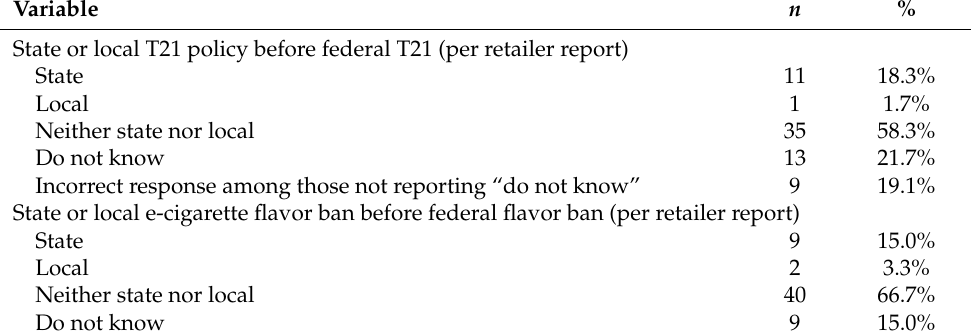
Table 2. Perceptions of tobacco regulations and COVID-19 orders on vape retail among vape and vape-and-smoke shop owners or managers, n =